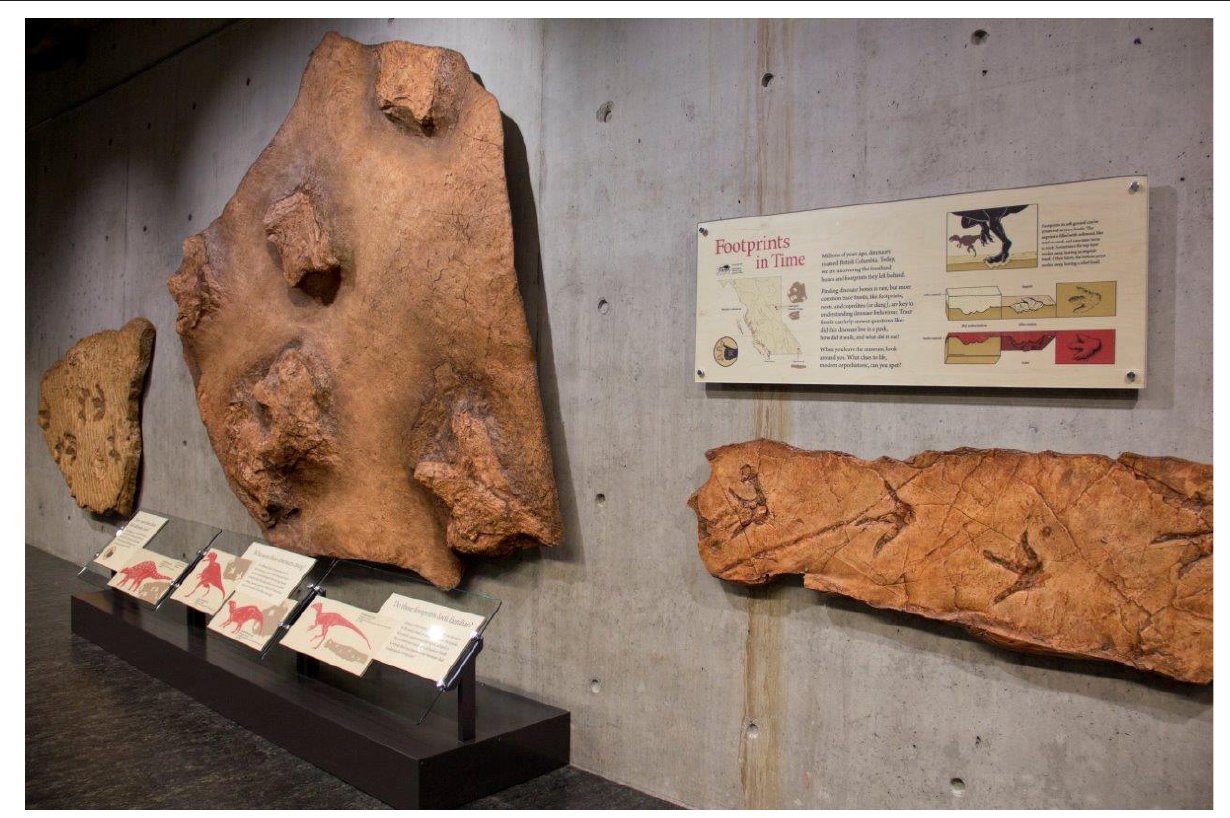
Figure 1. Footprints in Time exhibit at the Beaty Biodiversity Museum.